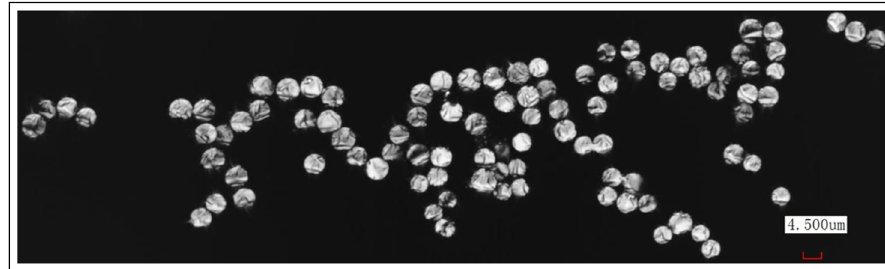
Figure 3: Synthetic laser image of a cross section of C1200 glass